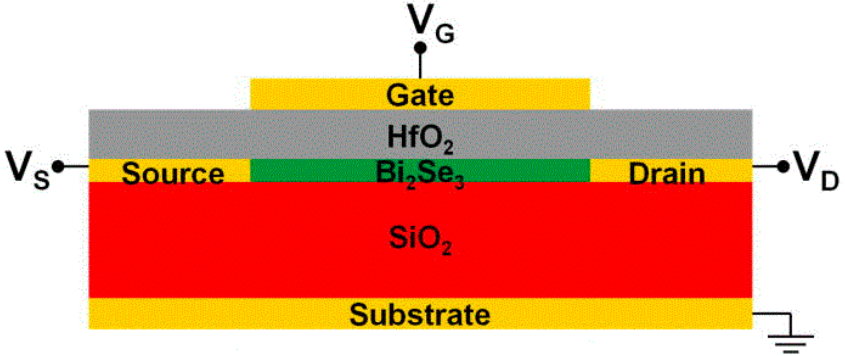
Figure 12. Device structure of Bi2Se3 metal-oxide semiconductor-field-effect transistor (MOS-FET). The nominal device parameters are as follows: Bi 2 Se 3 ( κ = 100) thin film = 1QL (~0.7 nm), HfO 2 ( κ = 25) gate oxide thickness = 2 nm, channel length = 20 and 50 nm, n-type doping density of source and drain = 1 × 10 13 cm − 2 [165].